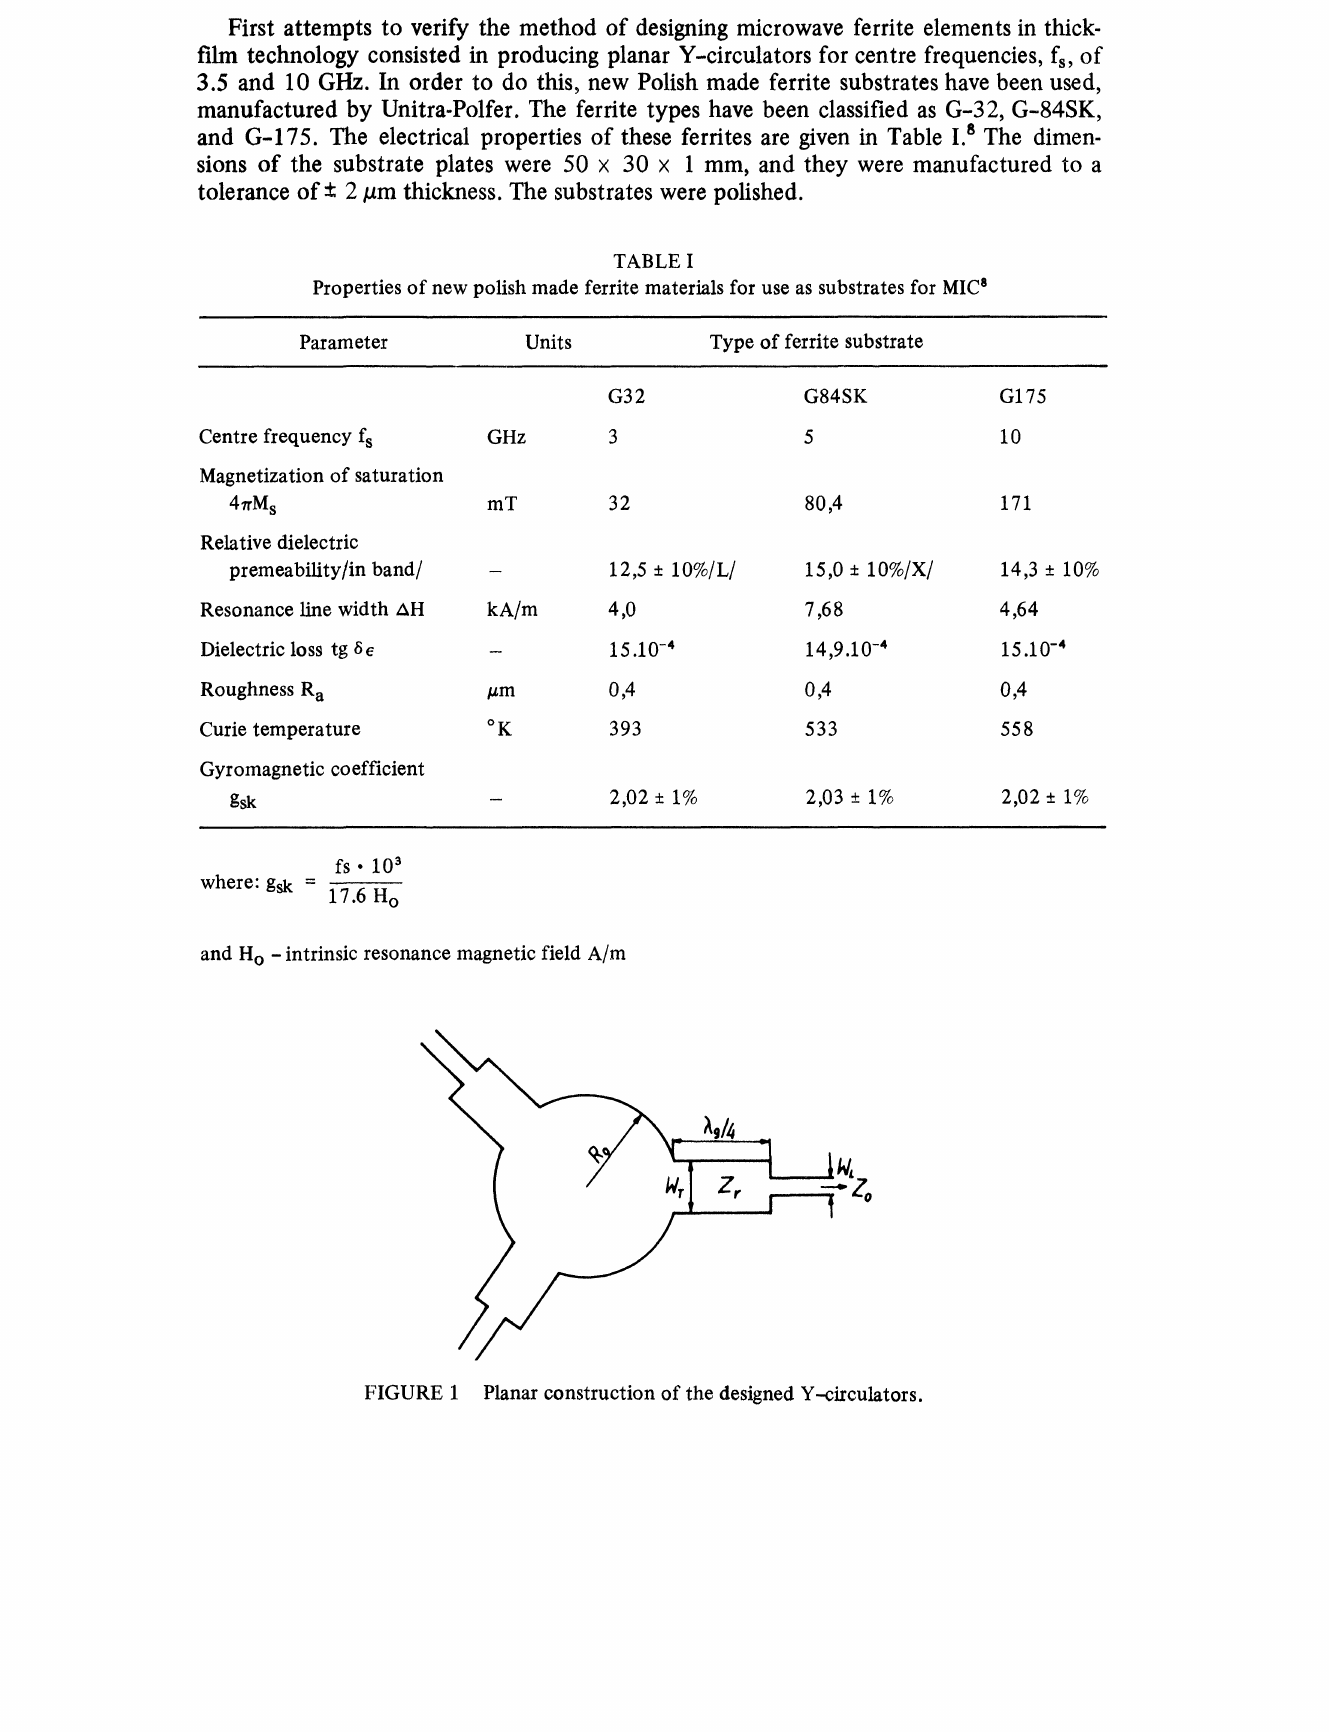
Planar construction of the designed